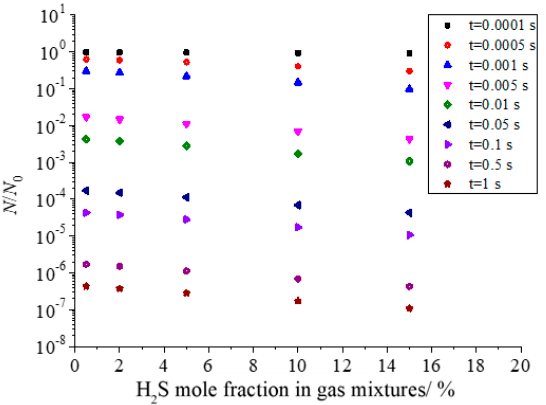
Figure 16. Effect of H 2 S concentration on the total number of dimensionless particles.